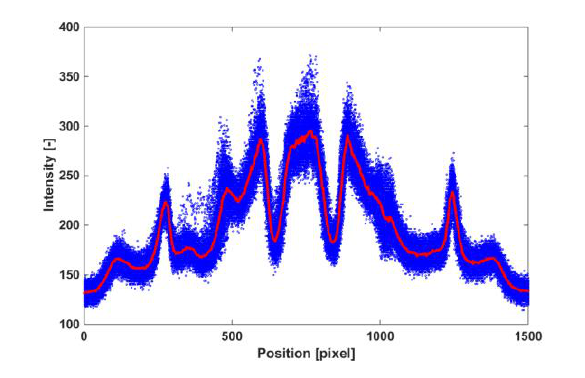
Fig. 5. C 9547-03, 25% gain, exposur time 300µs